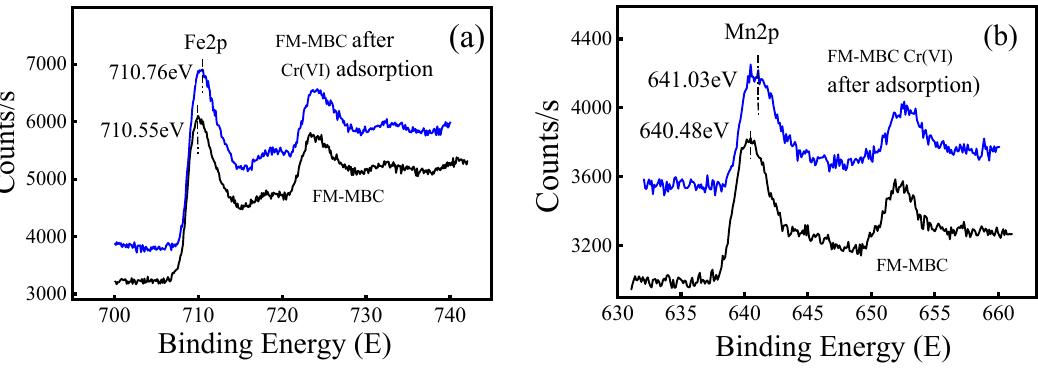
Figure 10. XPS spectra of FM-MBC before and after Cr(VI) adsorption, ( a ) Fe2p, ( b )